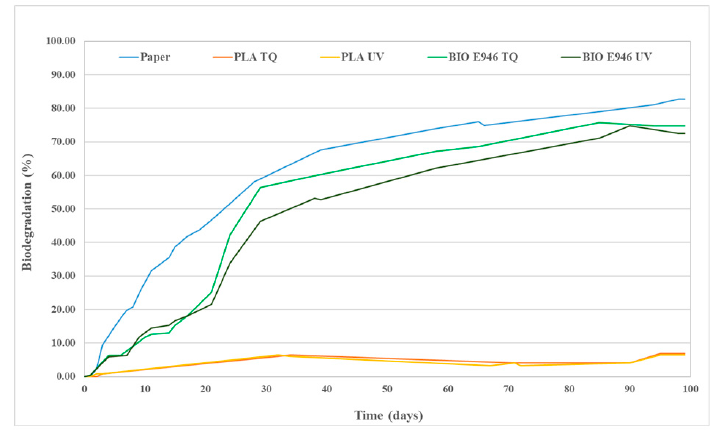
Figure 6. Biodegradation (%) as a function of time of PLA trays, BIO E946 film, UV treated and not (TQ) and paper (positive reference).